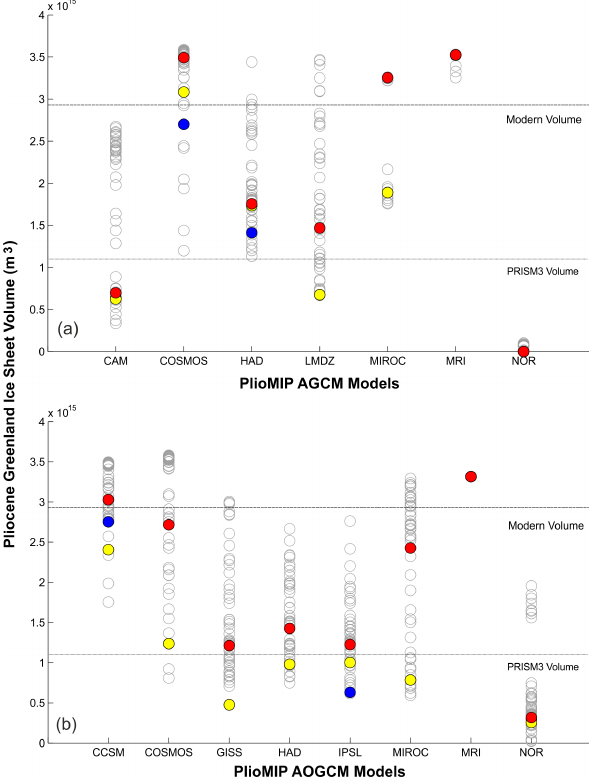
Figure 7. Simulated GrIS volume when BASISM is forced with the mPWP climatology from each of the (a) AGCM and (b) AOGCM PlioMIP models. The volume of the observed present- day GrIS (Bamber et al., 2001) is shown for comparison. Red- filled circles show the standard parameter set used within BASISM ( ∝ i = 8mmday − 1 ◦ C − 1 and ∝ s = 3mmday − 1 ◦ C − 1 , lapse rate = − 6 ◦ Ckm − 1 ) and blue-filled circles show the parameter set that gives a volumetric reconstruction closest to observed. Yellow-filled circles show the parameter set that gives the smallest RMSE in terms of simulated ice sheet thickness. Grey circles show the sen- sitivity of the ice sheet volume to different values of lapse rate and the PDD factors for ice and snow (see Table 2). The coloured circles are superimposed on the grey circles, so when the GrIS volume is similar, the grey circles (or individual colours) will not be